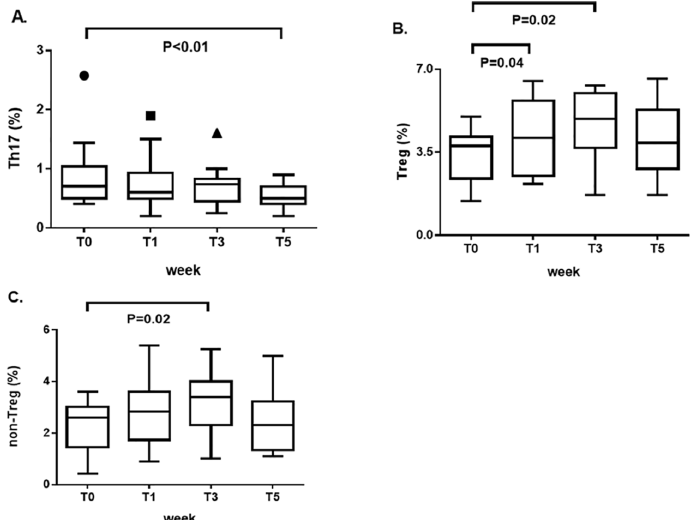
Fig 4. Change in the frequencies of Th17 and Treg cells (including the nTreg, eTreg, and non-Treg fractions) in the peripheral blood of patients with systemiclupus erythematosus at the main timepoints of the study set at T0 (baseline, before starting the low-sodium dietary regimen), T1 (after 1 week, at the end of the “run-in” period of low-sodium dietary regimen), T3 (after 3 weeks, at the end of low-sodium dietary regimen), and T5 (at the end of the study, after 2 weeks of normal sodium dietary regimen). (A) Reductionin the percentage of Th17 cells at T5 compared to T0. (B) Significant increasein the percentage of Treg cells at both T1 and T3 comparedto T0. (C) Significant increase in the percentageof non- Treg cells at T3 comparedto T0. Data are shown as Tukey boxplots; lines represent the median level with 25 th -75 th percentile;data not includedbetweenthe whiskersare plotted as outlierswith dots.